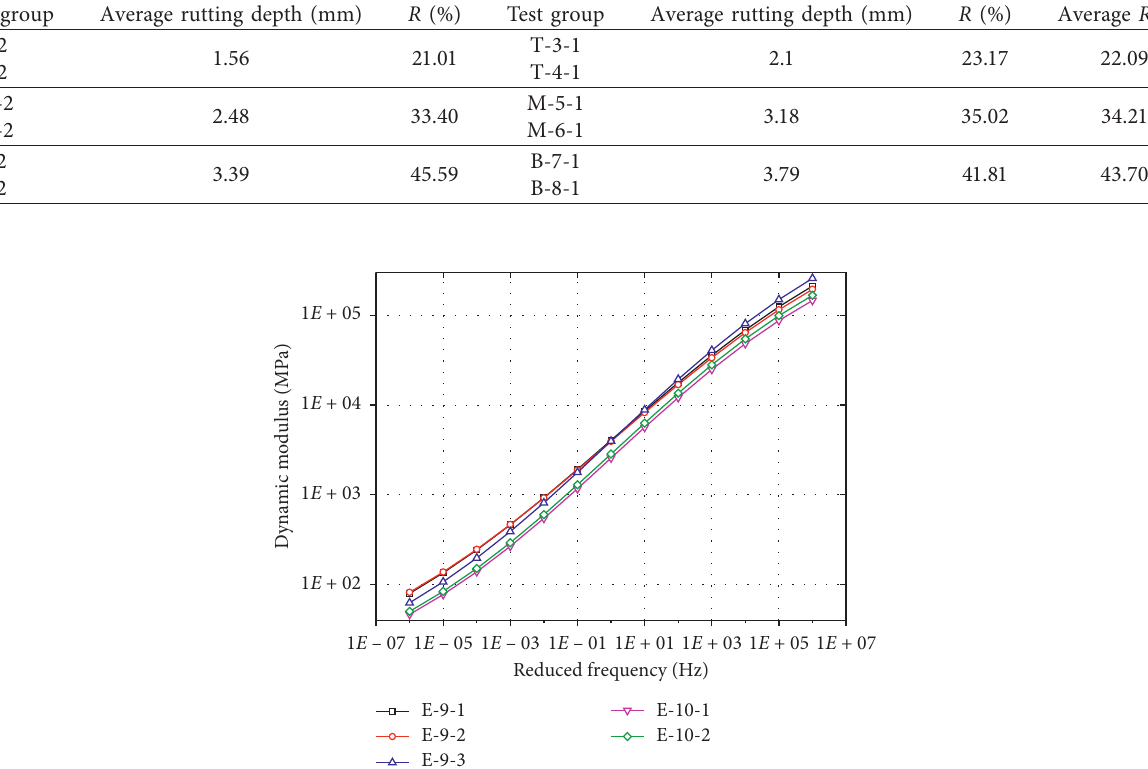
Figure 9: Dynamic modulus master curves at 21.1 °